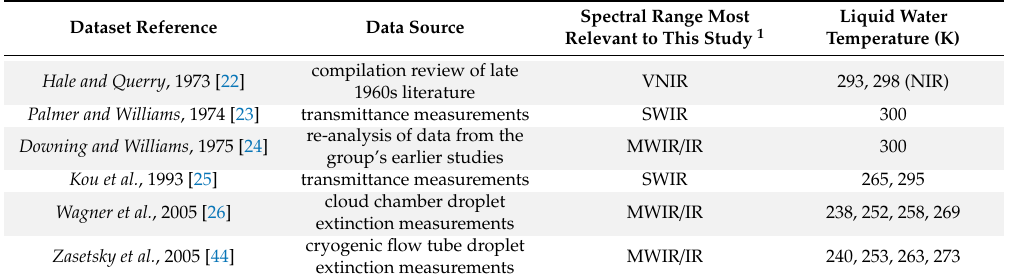
Table 2. Summary of liquid water complex index of refraction datasets examined in the